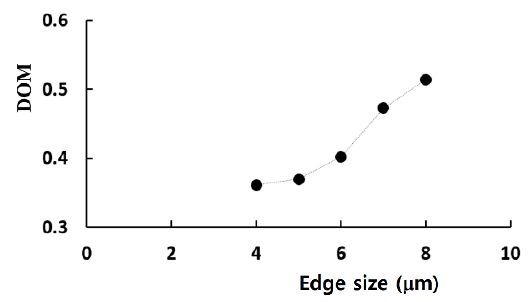
Figure 4. Grid dependence test.